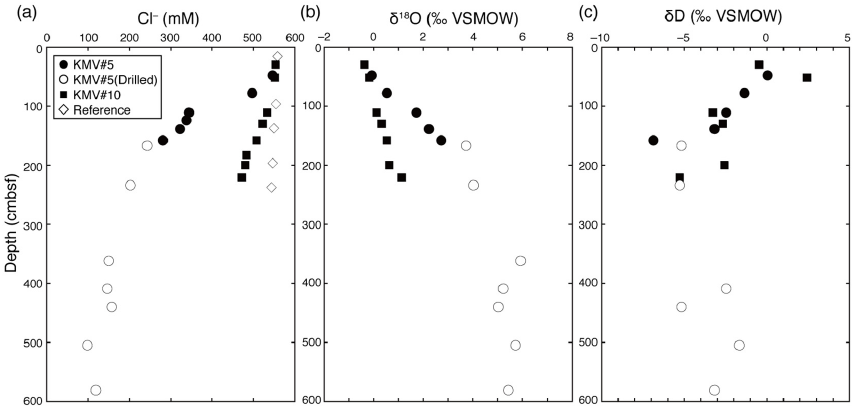
Figure 2. Vertical profiles of ( a ) Cl ‒ concentrations, ( b ) δ 18 O and ( c ) δ D in porewater samples